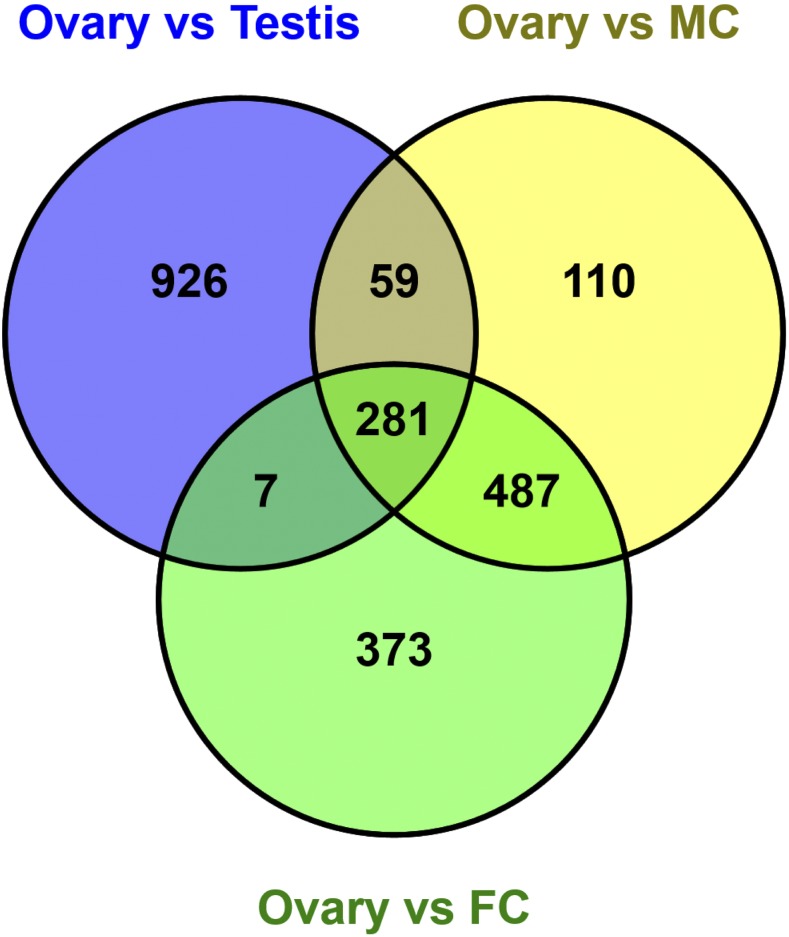
Highly expressed genes in the Tribolium ovary tissue. Venn diagrams representing increased gene expression greater than or equal to twofold in the Tribolium ovary in these comparisons (i.e., “Ovary vs Testis”, “Ovary vs Male carcass” and “Ovary vs Female carcass”).